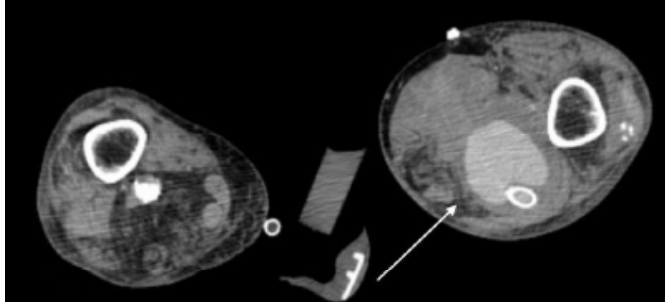
Image 2. Computed tomography angiography of the left lower extremity in axial view demonstrating popliteal artery aneurysm extension into a large left lower leg hematoma (arrow) status post popliteal artery stenting and